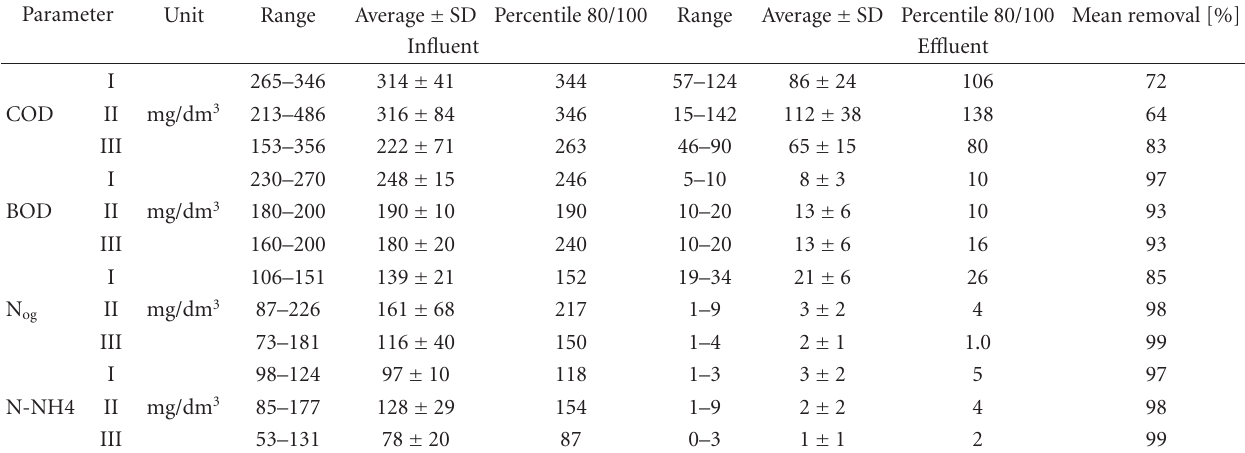
Table 5: Chemical characteristics of raw and treated wastewater (1% of leachate in influent I and II). Parameter